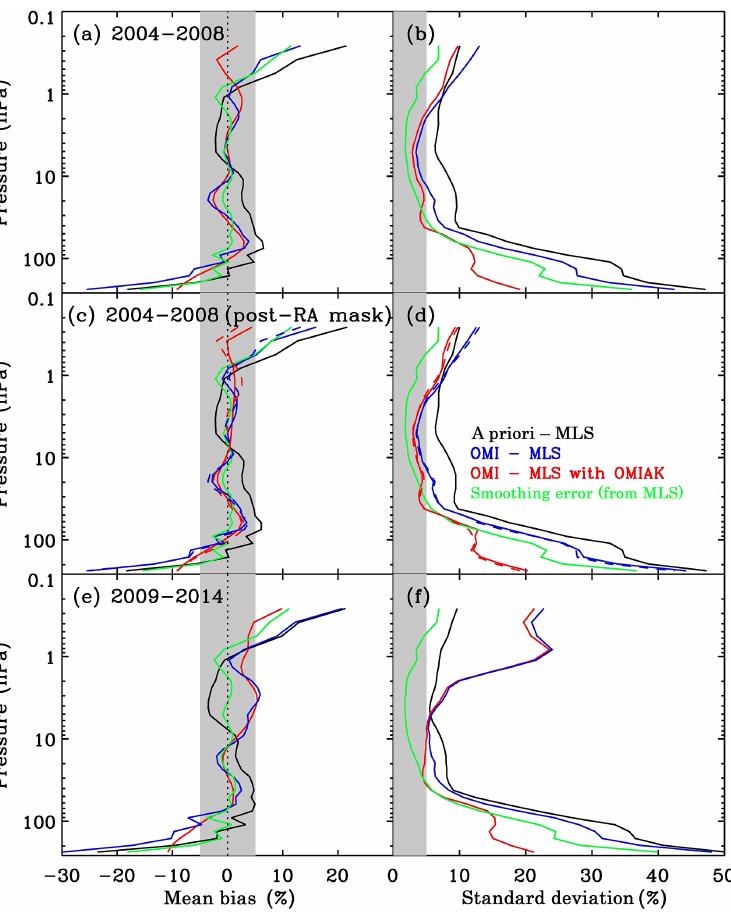
Figure 4. (a, c, e) Global mean biases at each MLS layer and (b, d, f) corresponding standard deviations of the differences between OMI and MLS profiles from 0.22 to 261hPa in (a, b) 2004–2008, (c, d) 2004–2008 with post-RA mask, and (e, f) 2009–2014, respectively. The black and blue lines compare a priori and OMI retrievals, respectively, with original MLS profiles. The red lines compare OMI retrievals with MLS profiles after applying OMI averaging kernels. The green lines represent OMI smoothing errors estimated by assuming MLS data as the truth. For contrast, the comparisons of OMI and MLS data based on the ideal collocation criteria in 2004–2008 are plotted in blue and red dashed lines in panels (c) and (d)